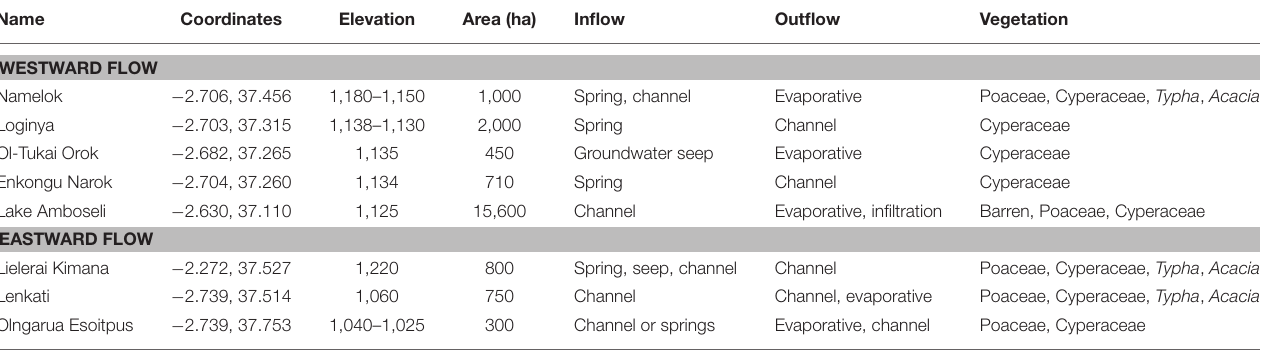
TABLE 2 | List of important wetlands in eastern Amboseli, arranged by